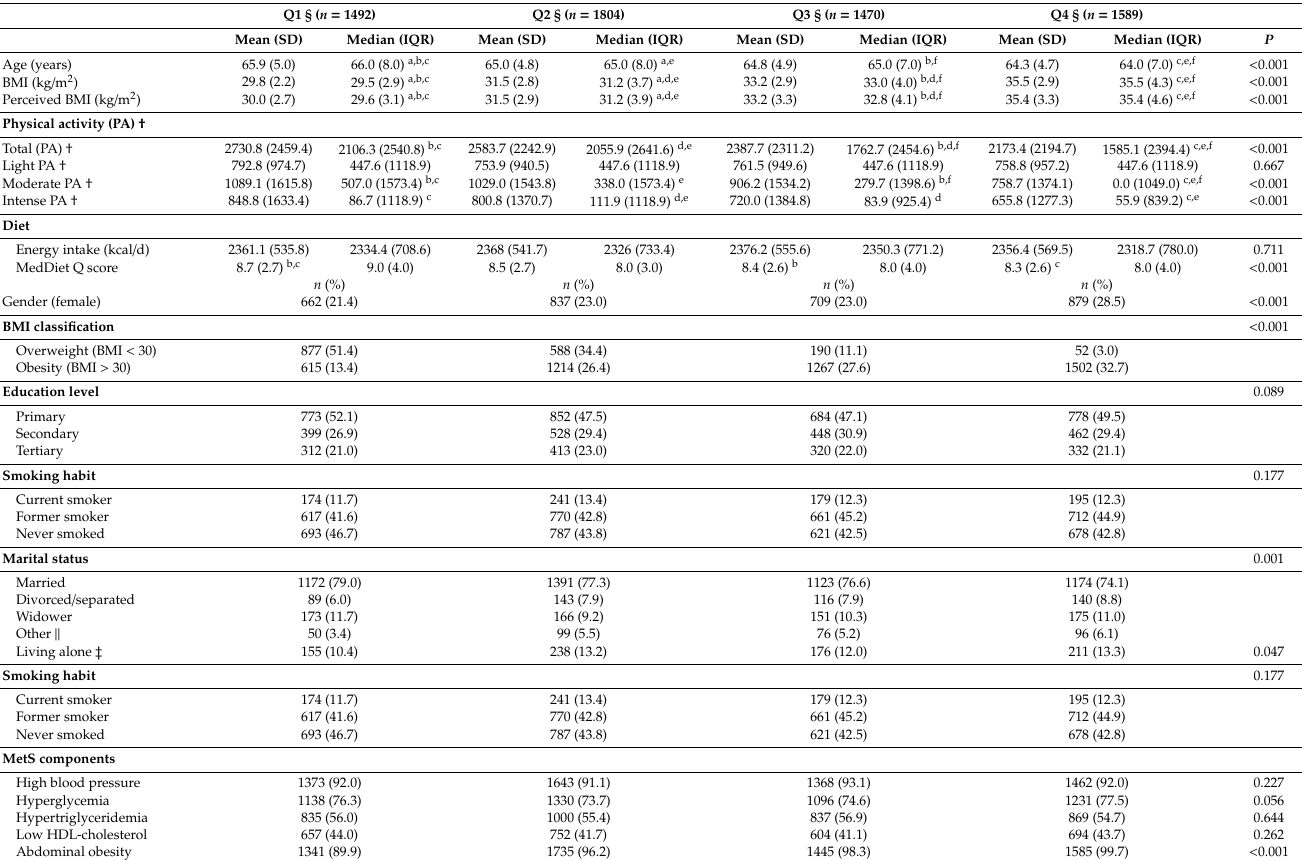
Table 2. Sociodemographic characteristics according to percentage of desired weight loss